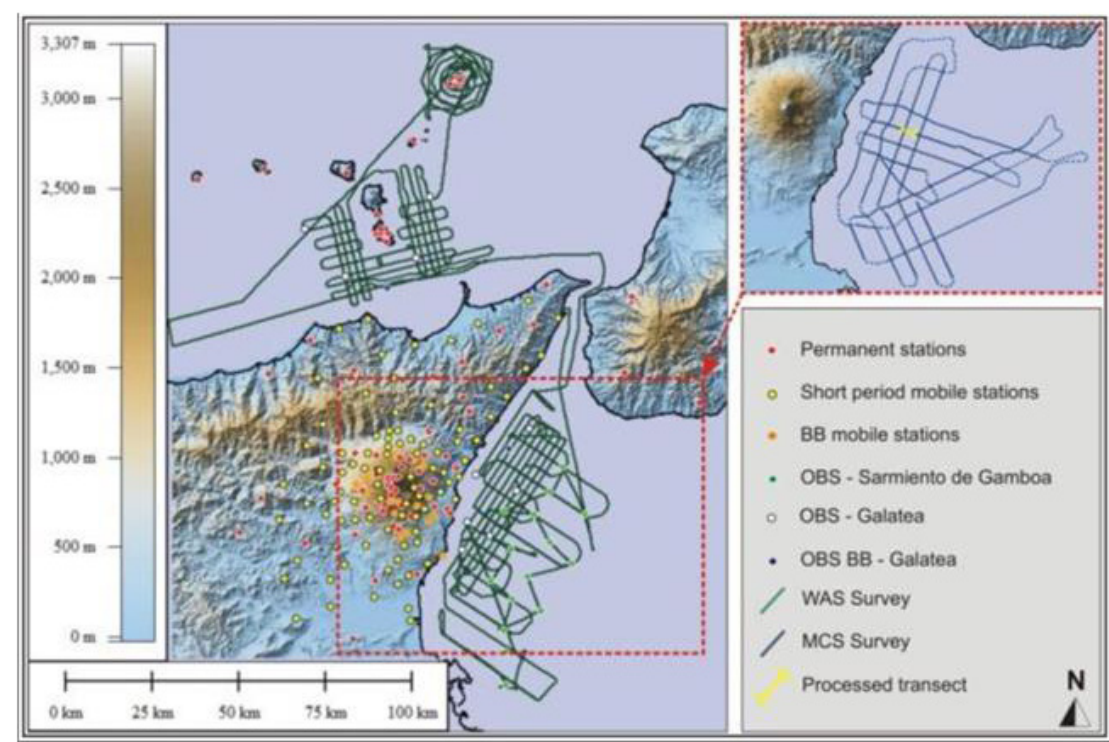
Figure 19. The whole route followed by the research vessel “Sarmiento de Gamboa” during the shooting